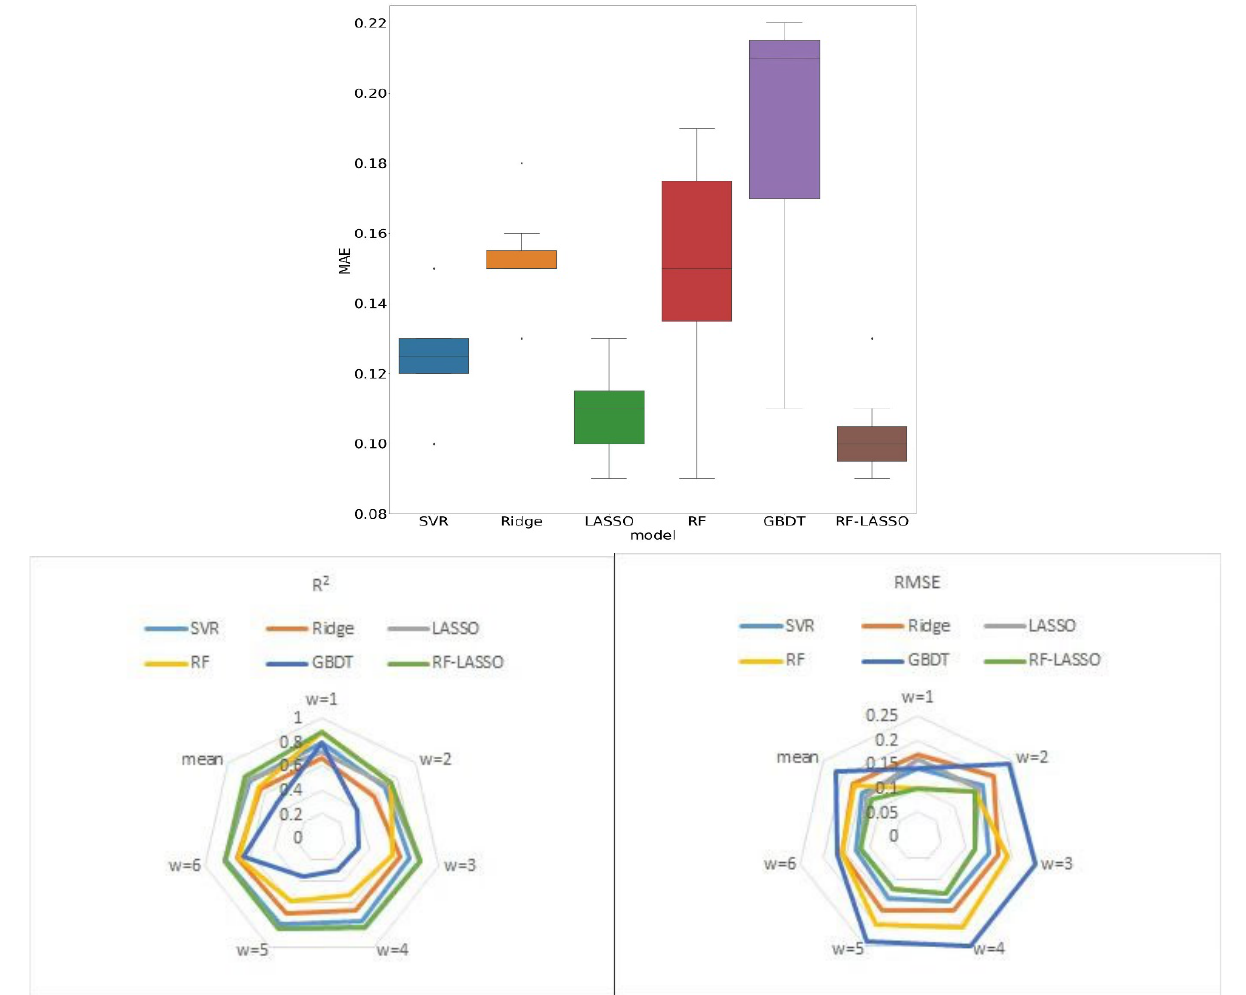
Figure 10. Comparative assessment of shallow learning models in the testing set.